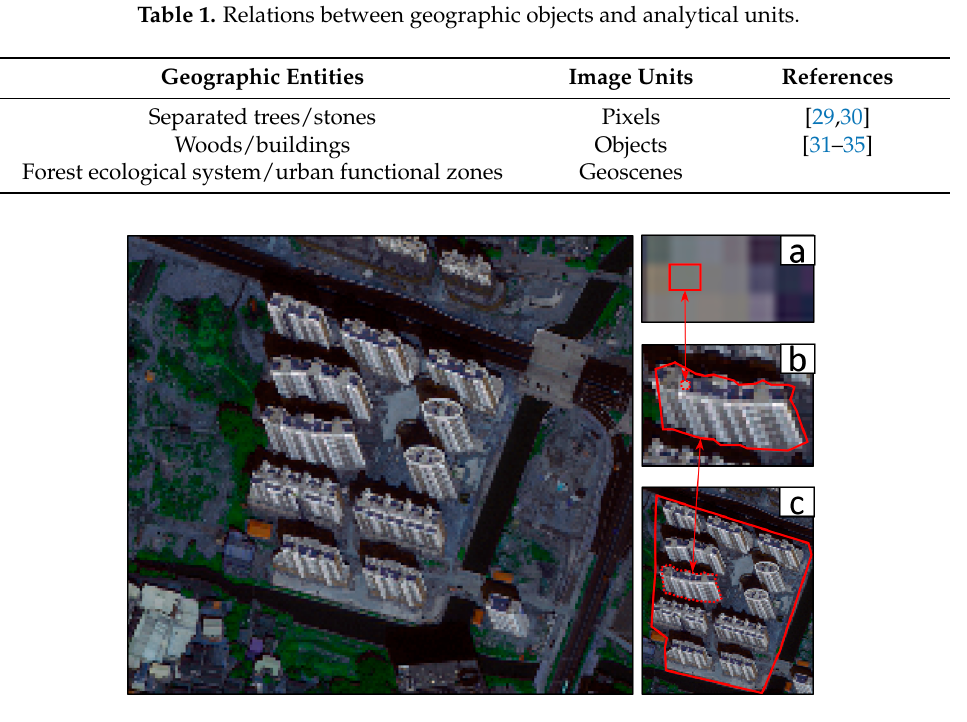
Figure 3. The relationships among: ( a ) a “building-material” pixel; ( b ) a “building” object; and ( c ) a “residential district” geoscene. The object in ( b ) is composed of many homogeneous pixels, while the geoscene in ( c ) consists of diverse objects. Table 1. Relations between geographic objects and analytical units.